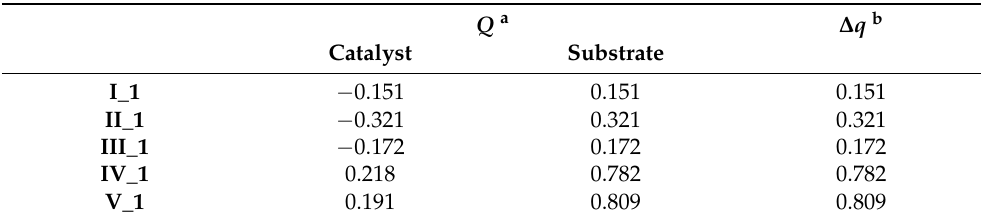
Table 3. Charge distribution of catalyst and substrate moieties of n _1 intermediate states ( n = I–V) obtained by NBO population